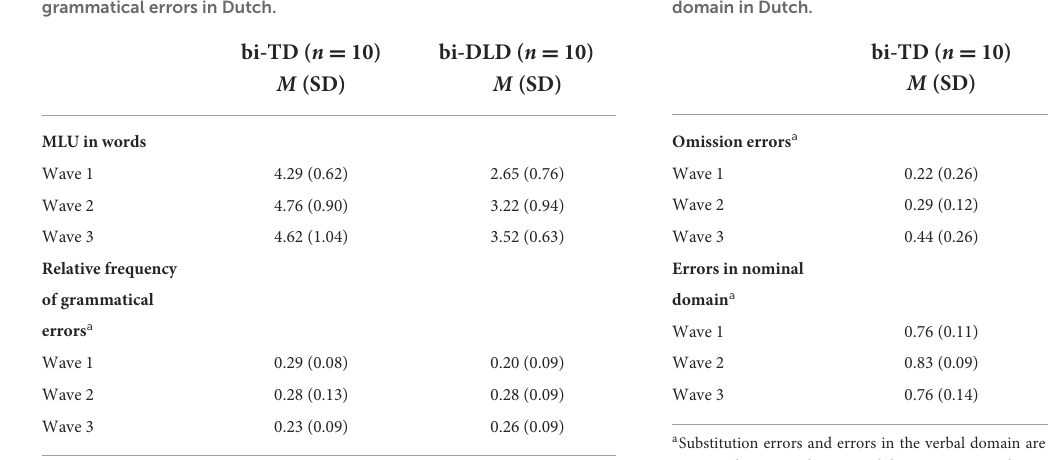
TABLE 6 Proportions of grammatical morpheme errors per type and domain in